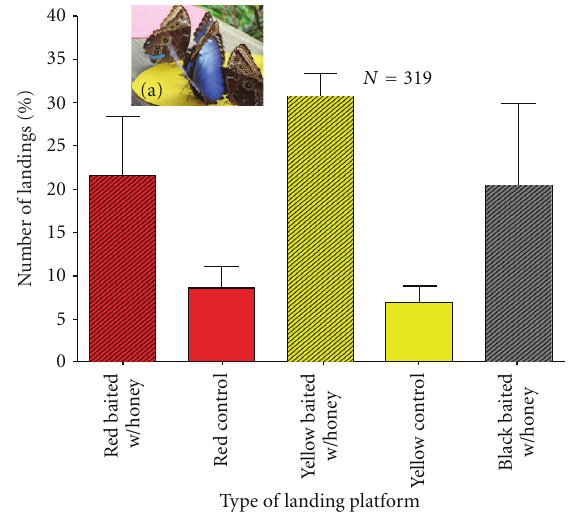
Figure 2: Bioassay I. Blue Morpho butterflies, Morpho helenor (a), showed a strong preference for baited landing platforms compared to nonbaited